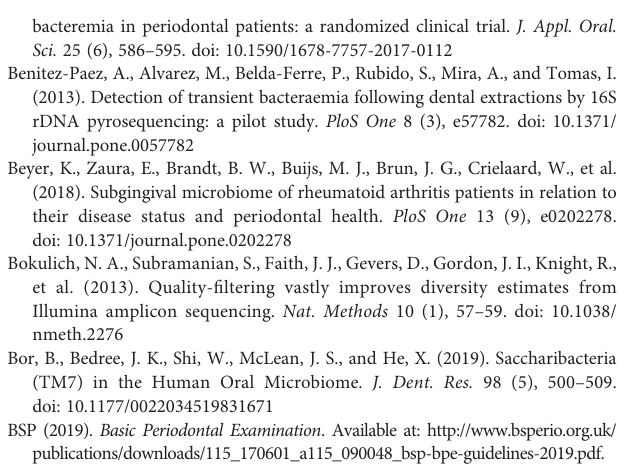
SUPPLEMENTARY TABLE 4 | Relative Abundance (Order). SUPPLEMENTARY TABLE 5 | Relative Abundance (Family). SUPPLEMENTARY TABLE 6 | Relative Abundance (Genus). SUPPLEMENTARY TABLE 7 | Relative Abundance